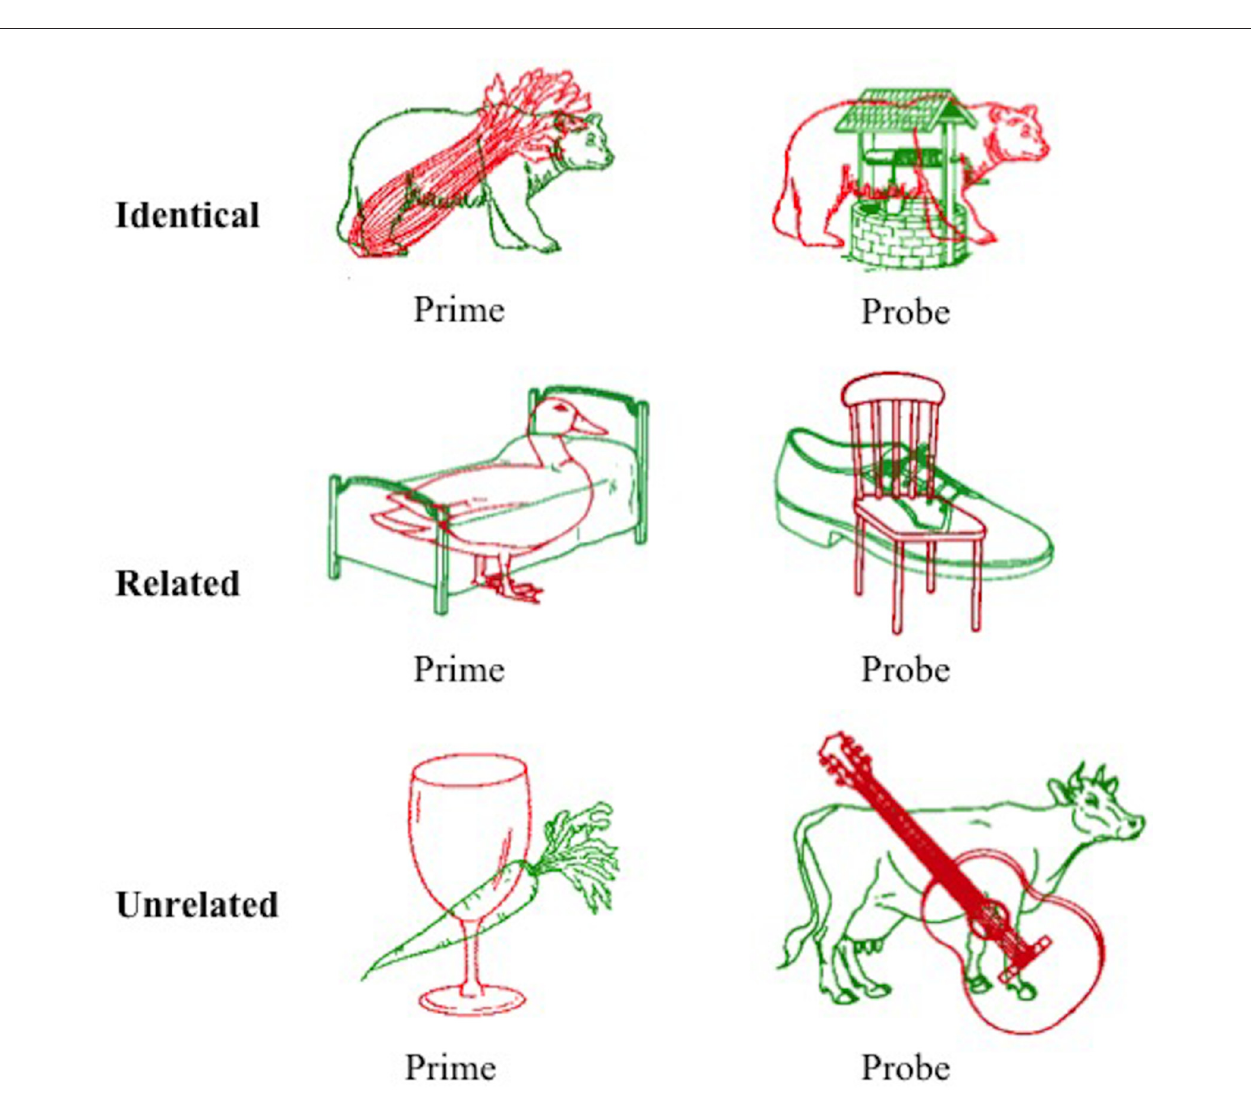
FIGURE 1 | Example of prime and probe stimuli from the three conditions of the negative priming task. Participants were required to name the red item and ignore the green item. Images were adapted from the International Picture Naming Project, see Szekely et al.